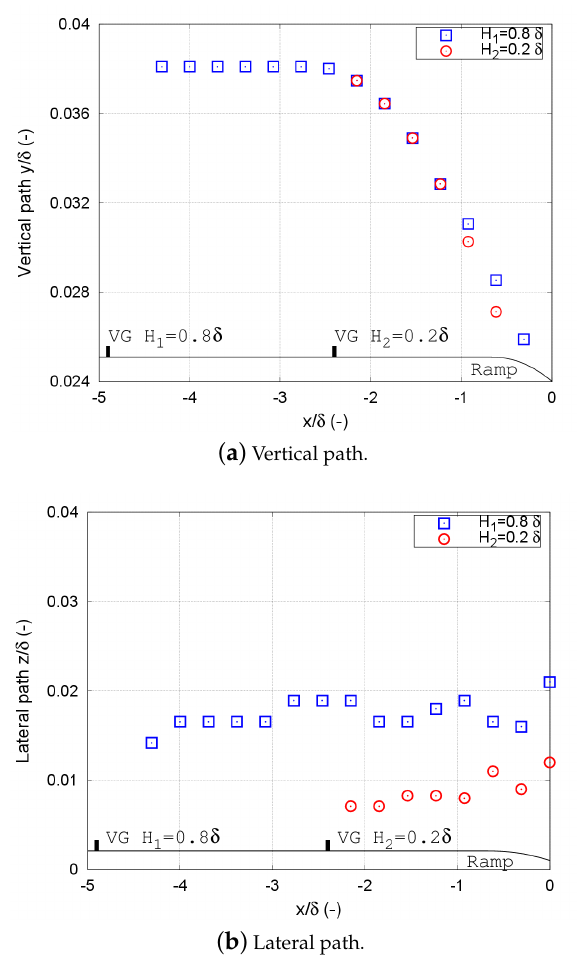
Figure 11. Normalized vertical ( a ) and lateral ( b ) paths function of the normalized distance x / δ from the backward-facing ramp for the H 1 = 0.8 δ (blue rectangles) and H 2 = 0.2 δ (red circles) vane-type VG cases. VGs, flat plate and ramp are also shown (not at